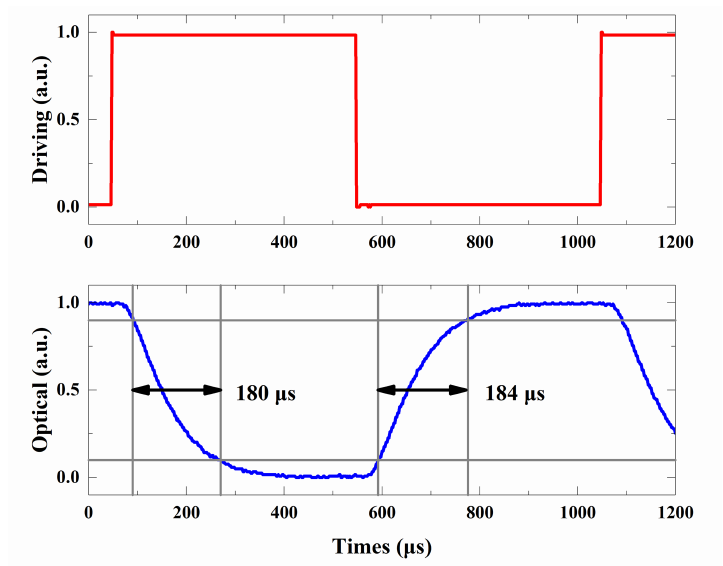
Figure 4. Time response of the broadband